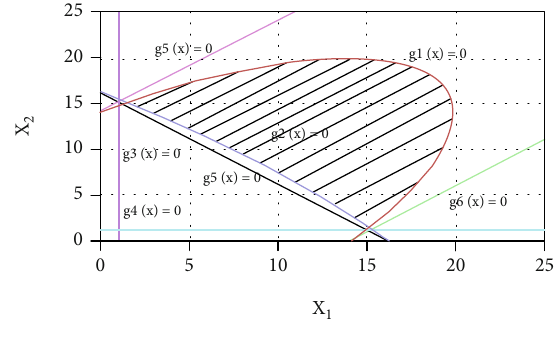
Figure 25: Constraint planning area.